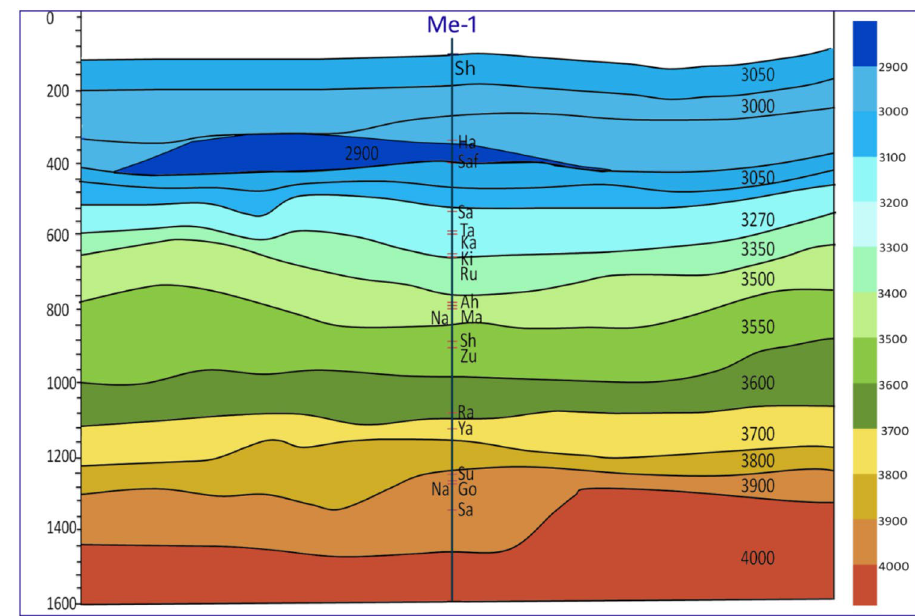
Fig. 10 Velocity model is con- structed from average and root mean square velocity which is used in depth